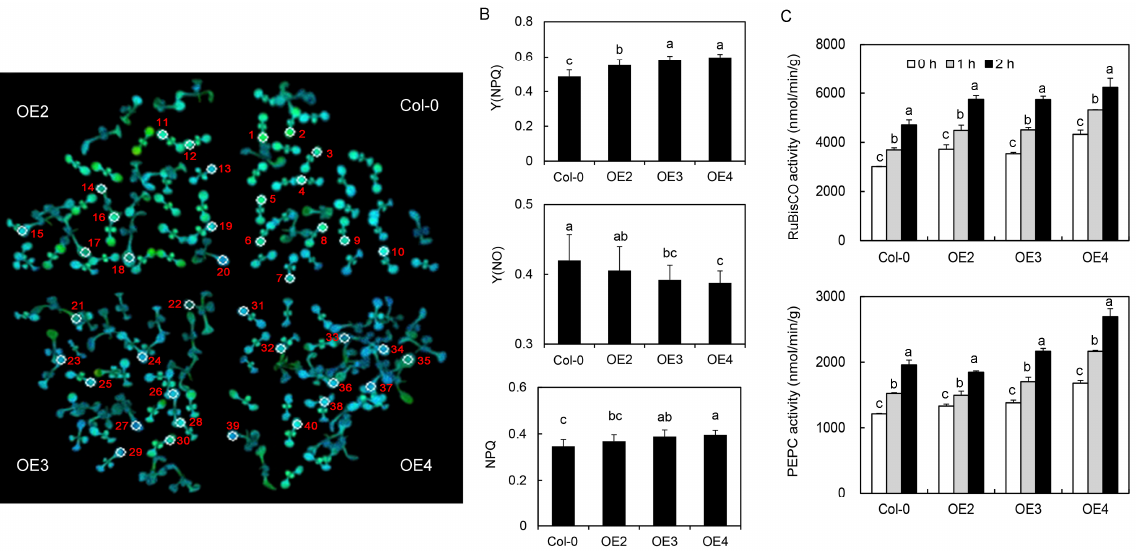
Figure 5. Analysis of chlorophyll a fluorescence in different lines under high-temperature treatment. ( A ) Chlorophyll a fluorescence imaging. ( B ) Changes in chlorophyll a fluorescence parameters of four lines under heat treatment. Different letters over bars indicate significant differences among different lines ( p < 0.05). ( C ) RuBisCO and PEPC activities in the four lines under high-temperature treatment. Different letters over bars indicate significant difference in the same lines and under different treatments ( p < 0.05).